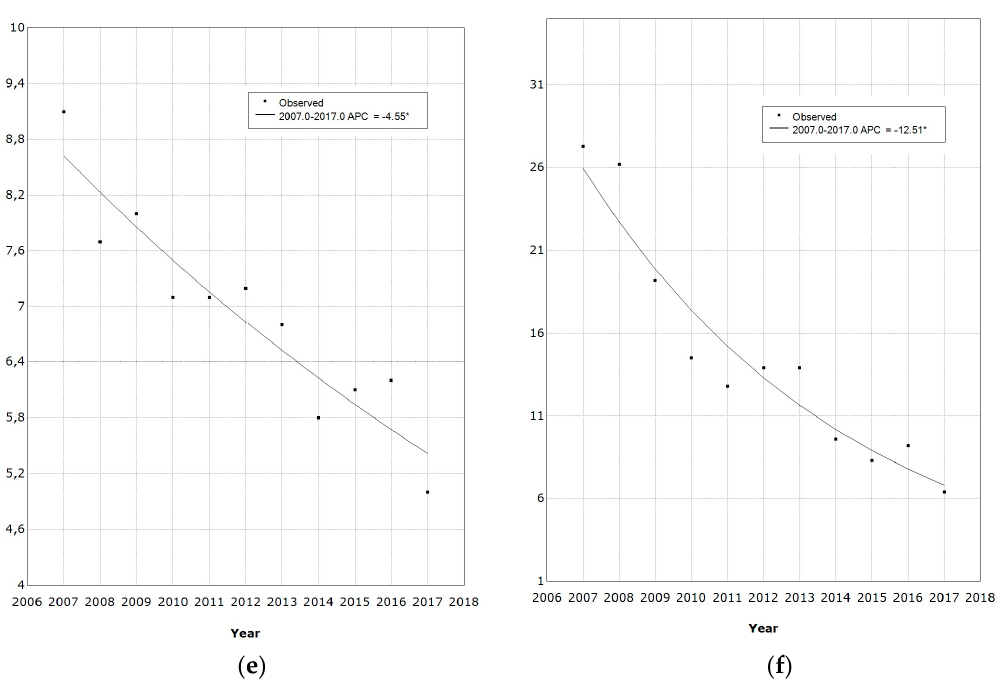
Figure 1. Trends and average annual percentage change (APC) observed for HPV-related hospitalization rates from 2007 to 2017. ( a ) Cervical cancer; ( b ) Oropharynx cancer; ( c ) Anus cancer; ( d ) Penis cancer; ( e ) Vulva and vagina cancer; ( f ) Genital warts. * Indicates that the APC is significantly different from zero at the alpha = 0.05 level.